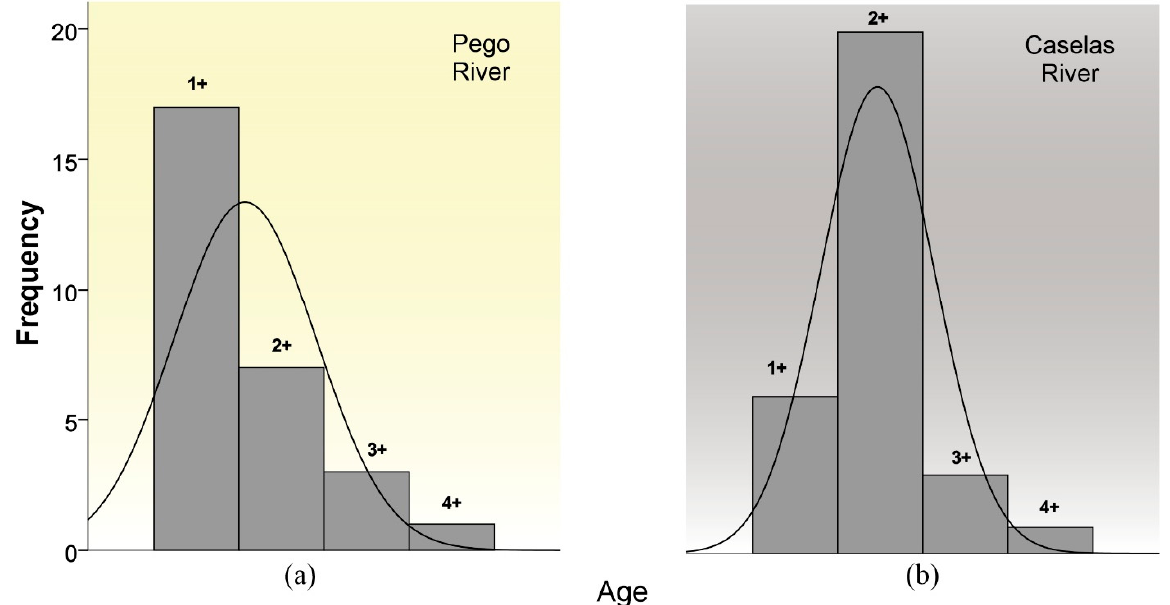
Figure 3. Frequency of age classes of G. lozanoi in the rivers ( a ) Pego and ( b ) Caselas.